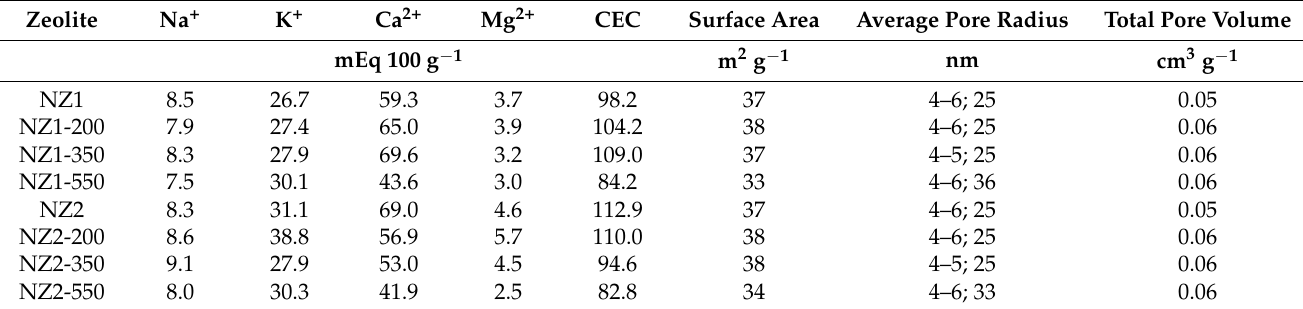
Table 3. Exchangeable cations content, the sum of exchangeable cations (CEC), surface area and